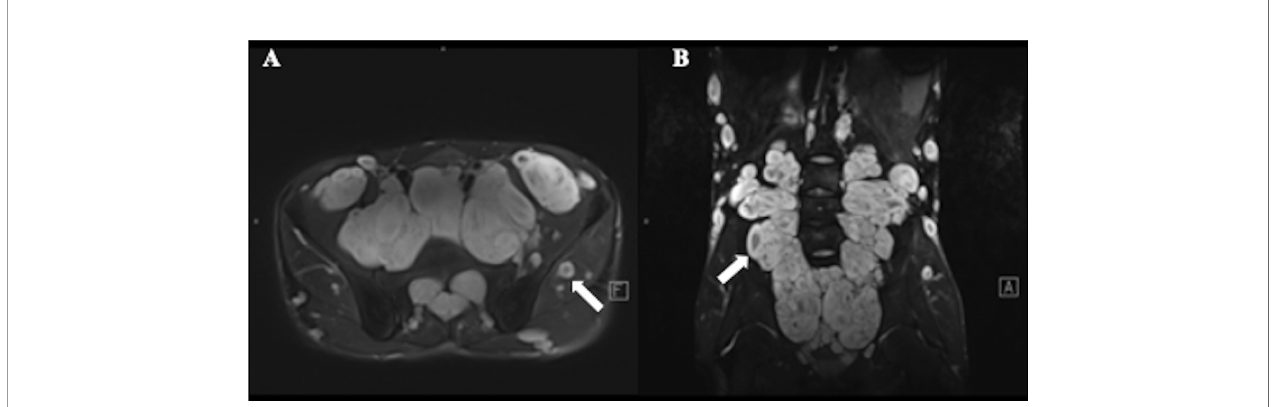
FIGURE 2 | A 17-year-old male with plexiform neuro fi broma (PNF) who presented multiple masses throughout the body. T2-weighted MR image showed a target sign (arrow) with peripheral area of high intensity and central area of low intensity. (A) Multiple nodules and lumps in the walking area of the bilateral femoral nerve, sciatic nerve, and obturator nerve; (B) Multiple nodules and lumps in the epidermis, subcutaneous and soft tissues of the abdomen and pelvis.